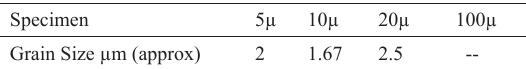
Table 7: Grain Size in Stir Zone (SZ) measured by the planimetric